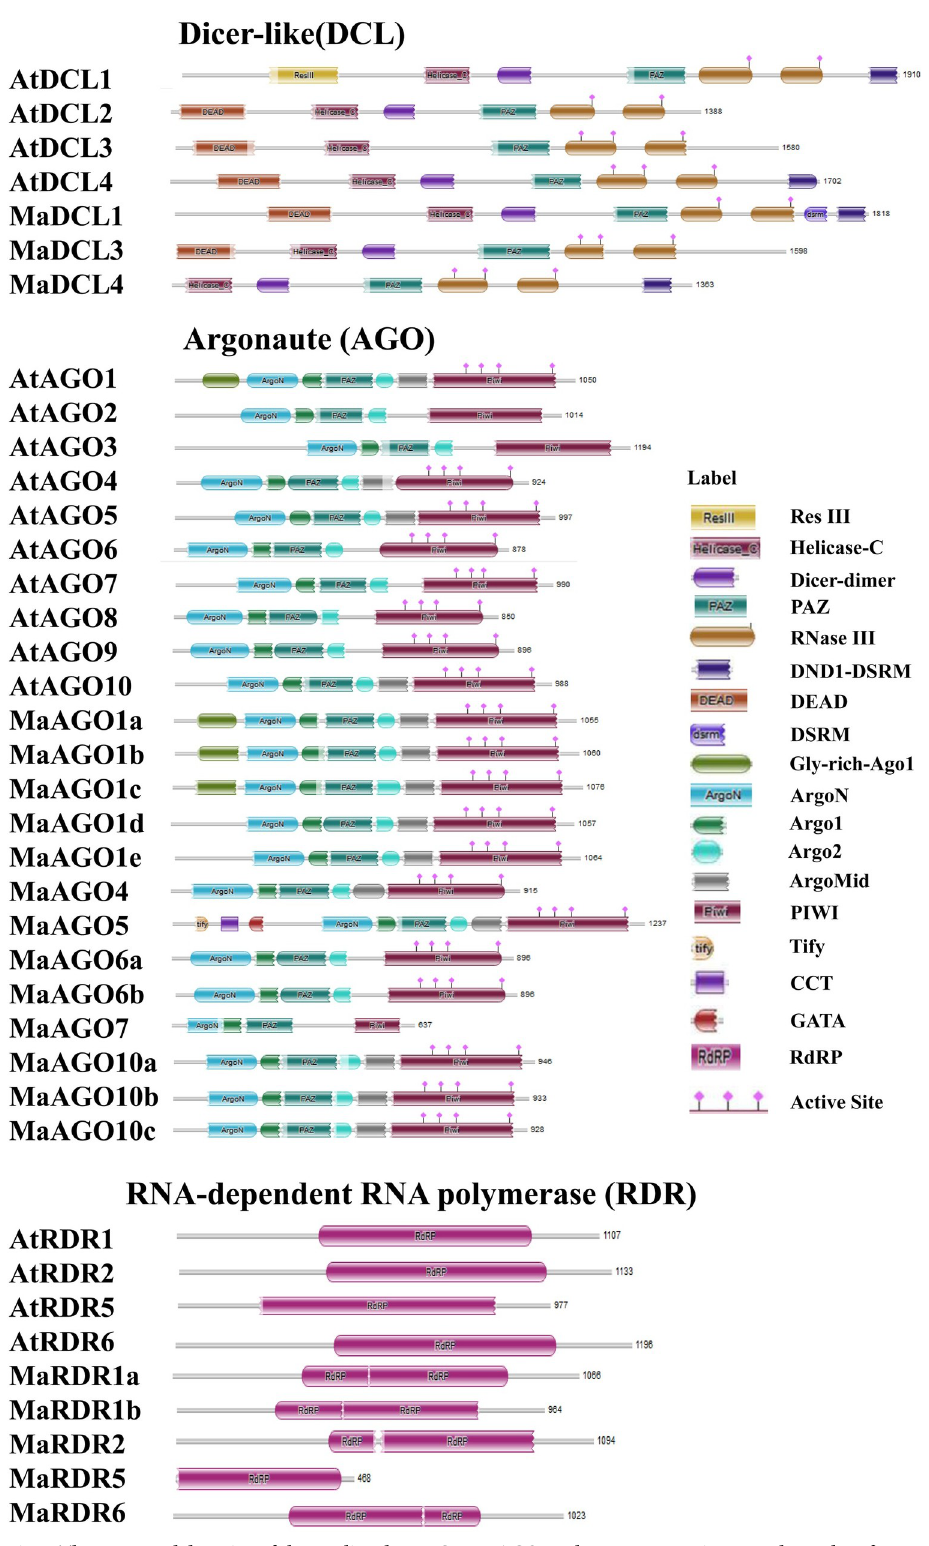
Fig 6. The conserved domains of the predicted MaDCL, MaAGO, and MaRDR proteins were drawn by Pfam database information. Where, Helicase conserved C-terminal domain: Helicase-C; Dicer dimerization